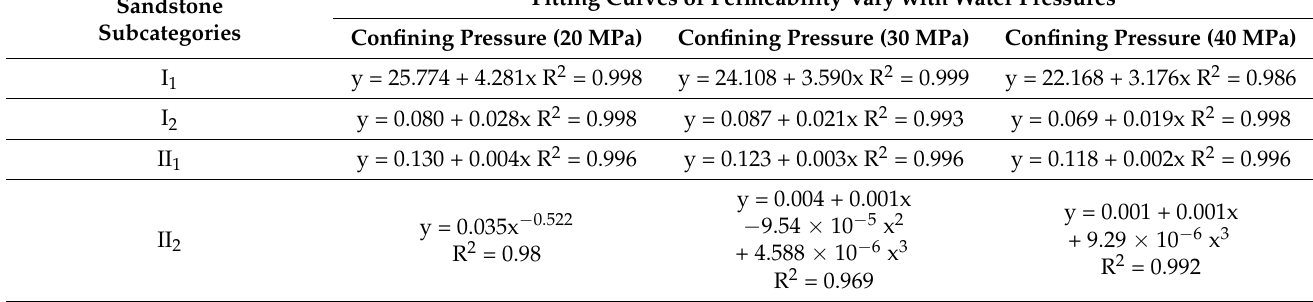
Table 5. Functional relationships between permeability and water pressure under different confin- ing